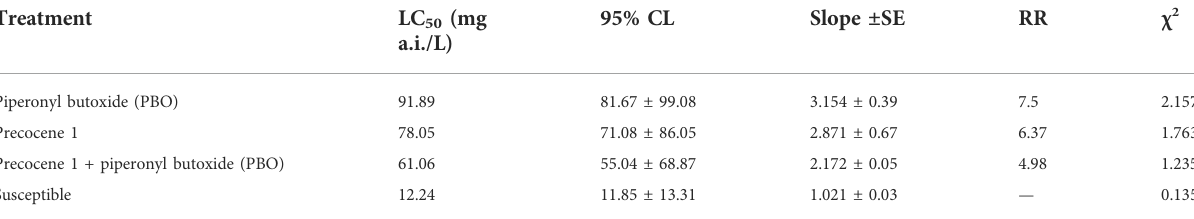
TABLE 2 Synergistic effect of piperonyl butoxide on the susceptibility of third-instar larvae of S. litura to lambda-cyhalothrin after the ingestion of Precocene 1.